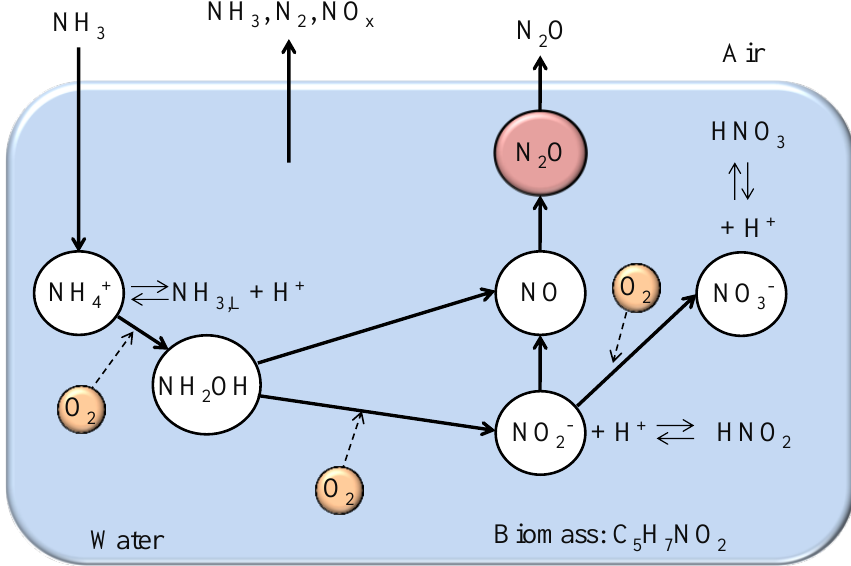
Figure 2. Nitrogen species in water.